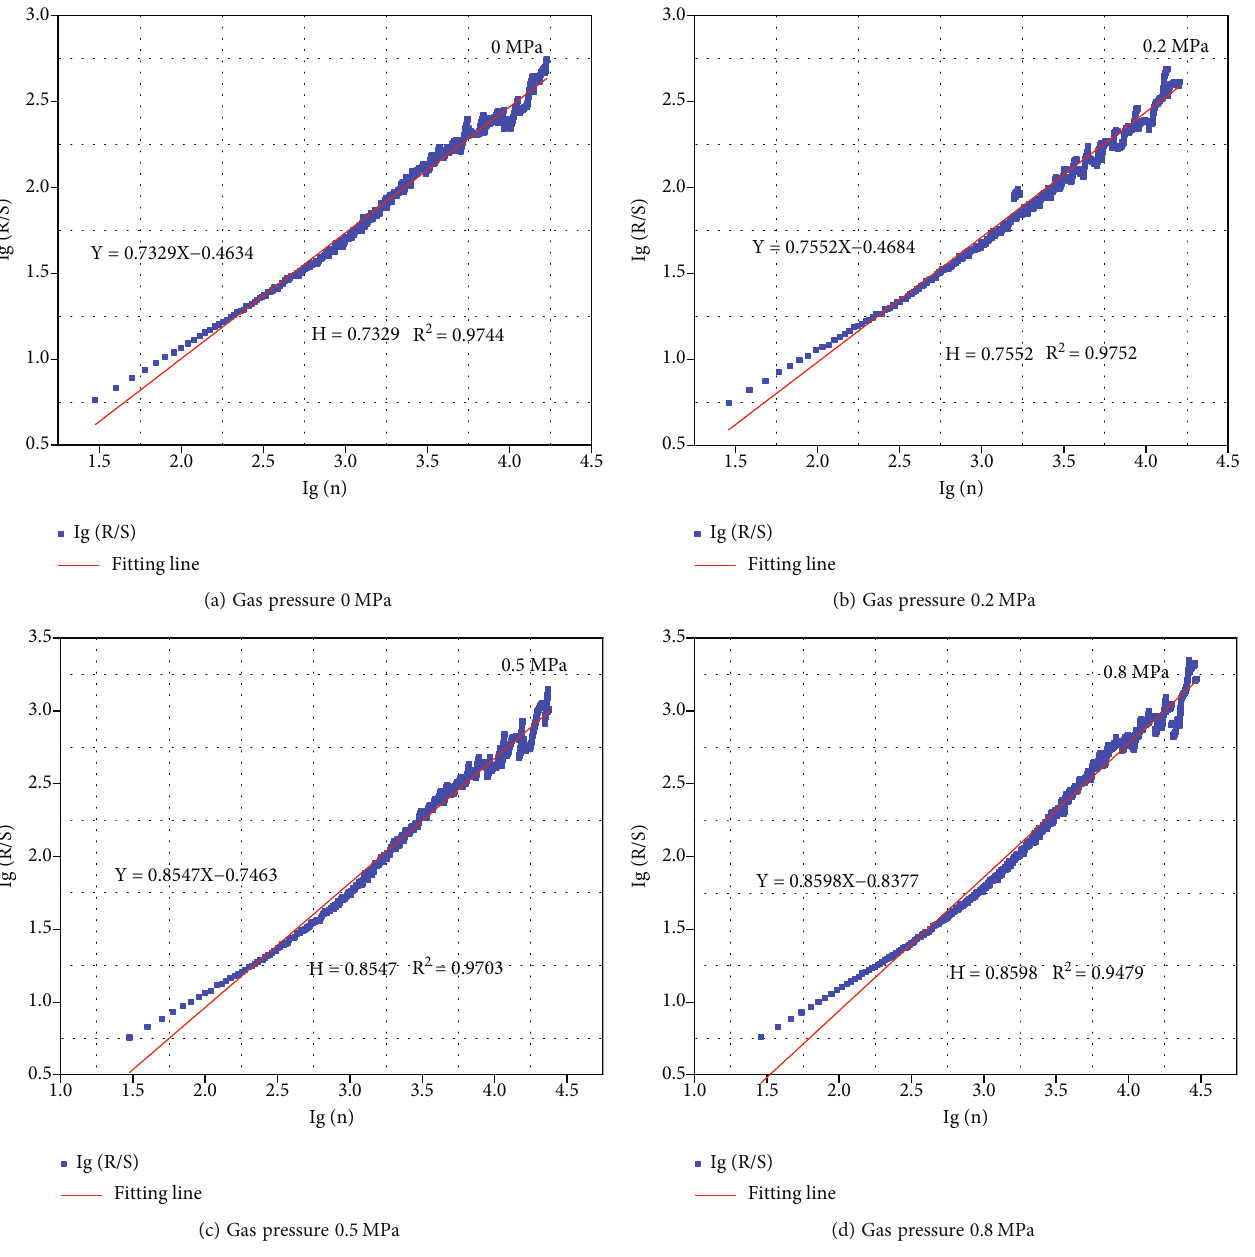
Figure 6: R / S statistical rule of acoustic emission